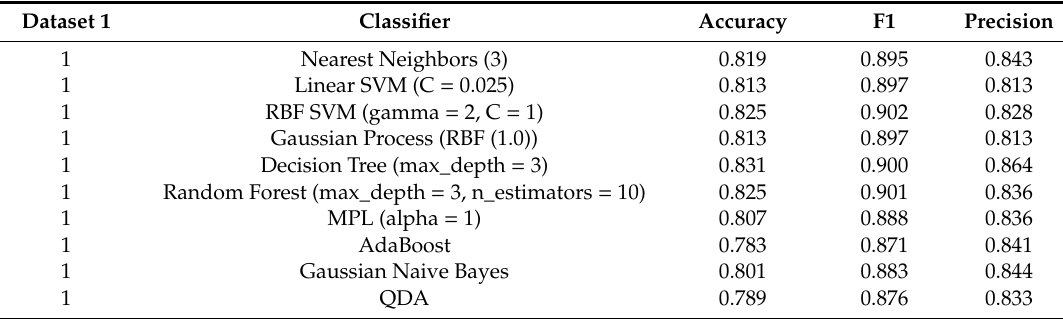
Table 5. Classifier